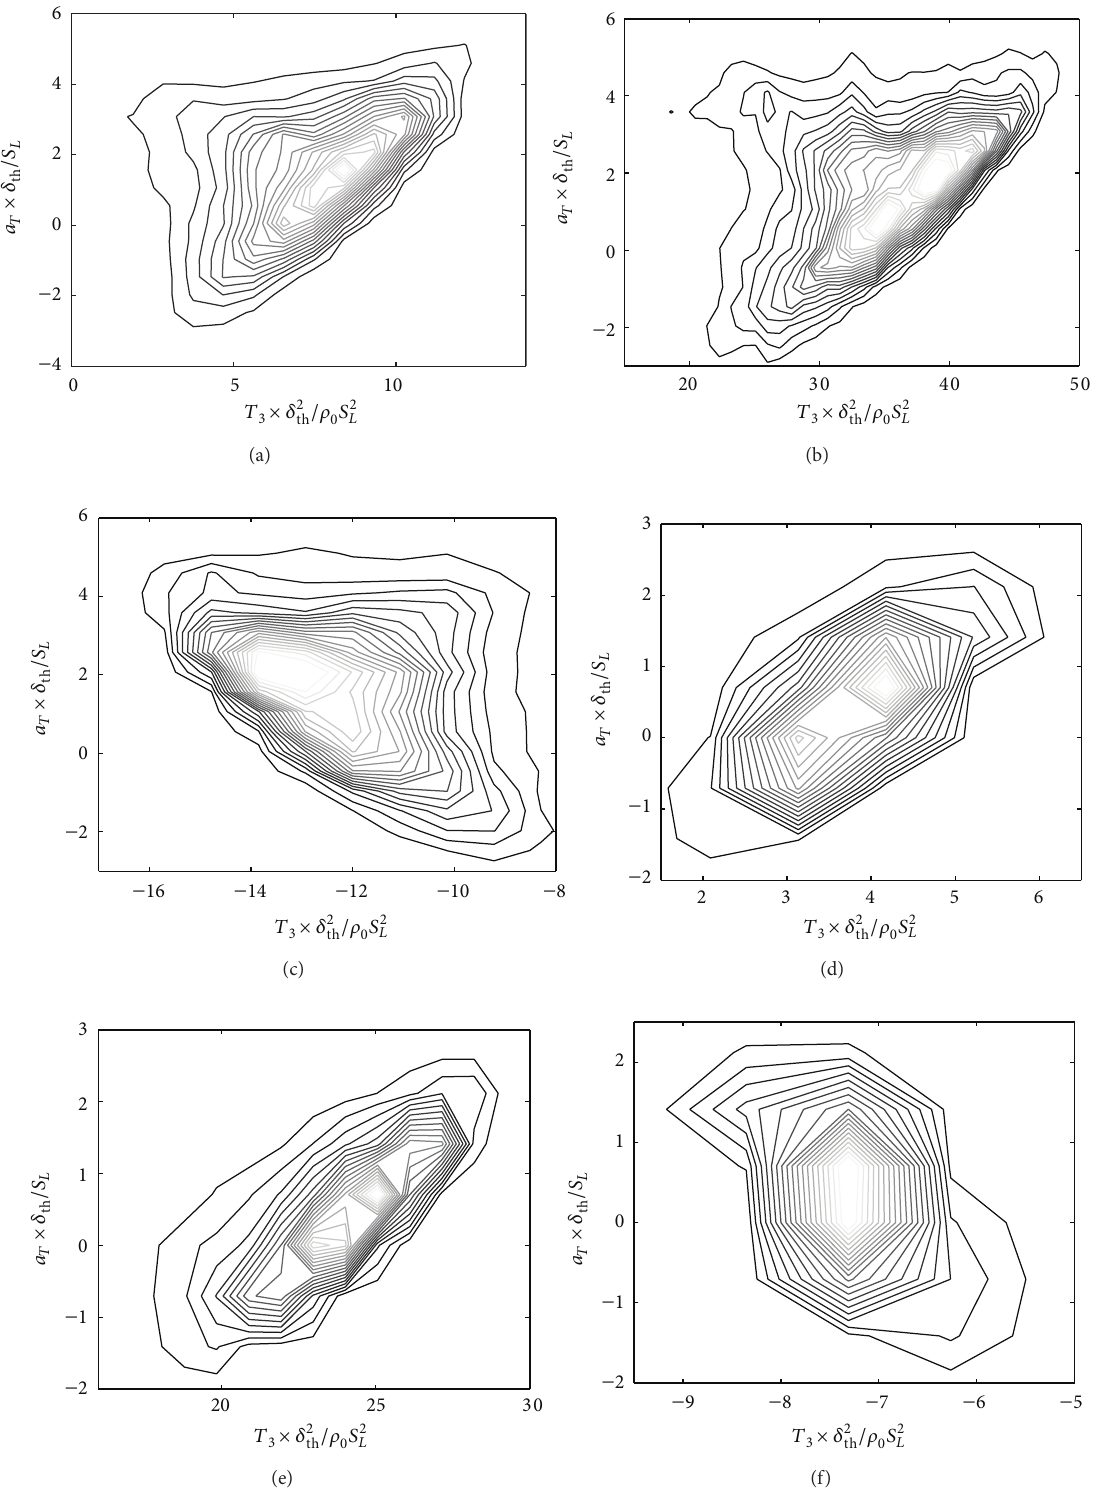
/𝜌 𝑆 2 0 𝐿 and normalised tangential strain rate th